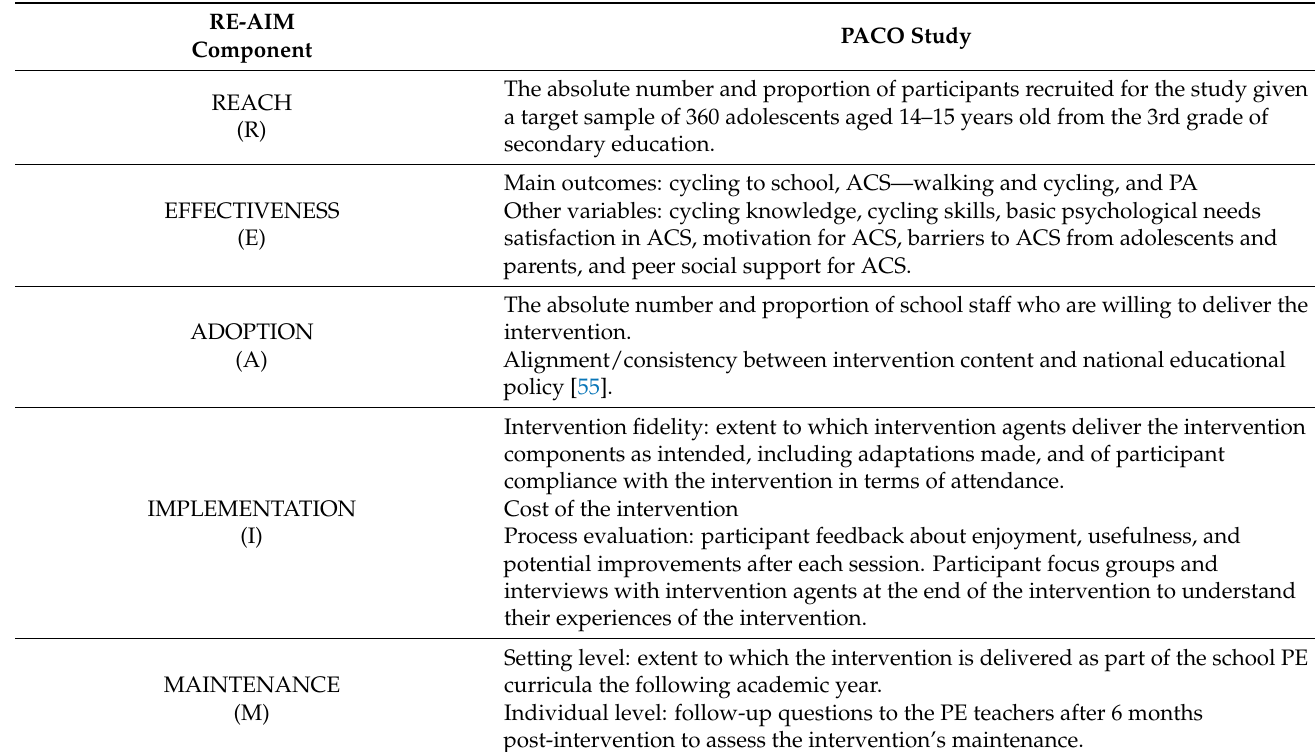
Table 2. Reach Effectiveness Adoption Implementation Maintenance (RE-AIM) components and dimensions to be evaluated in the PACO